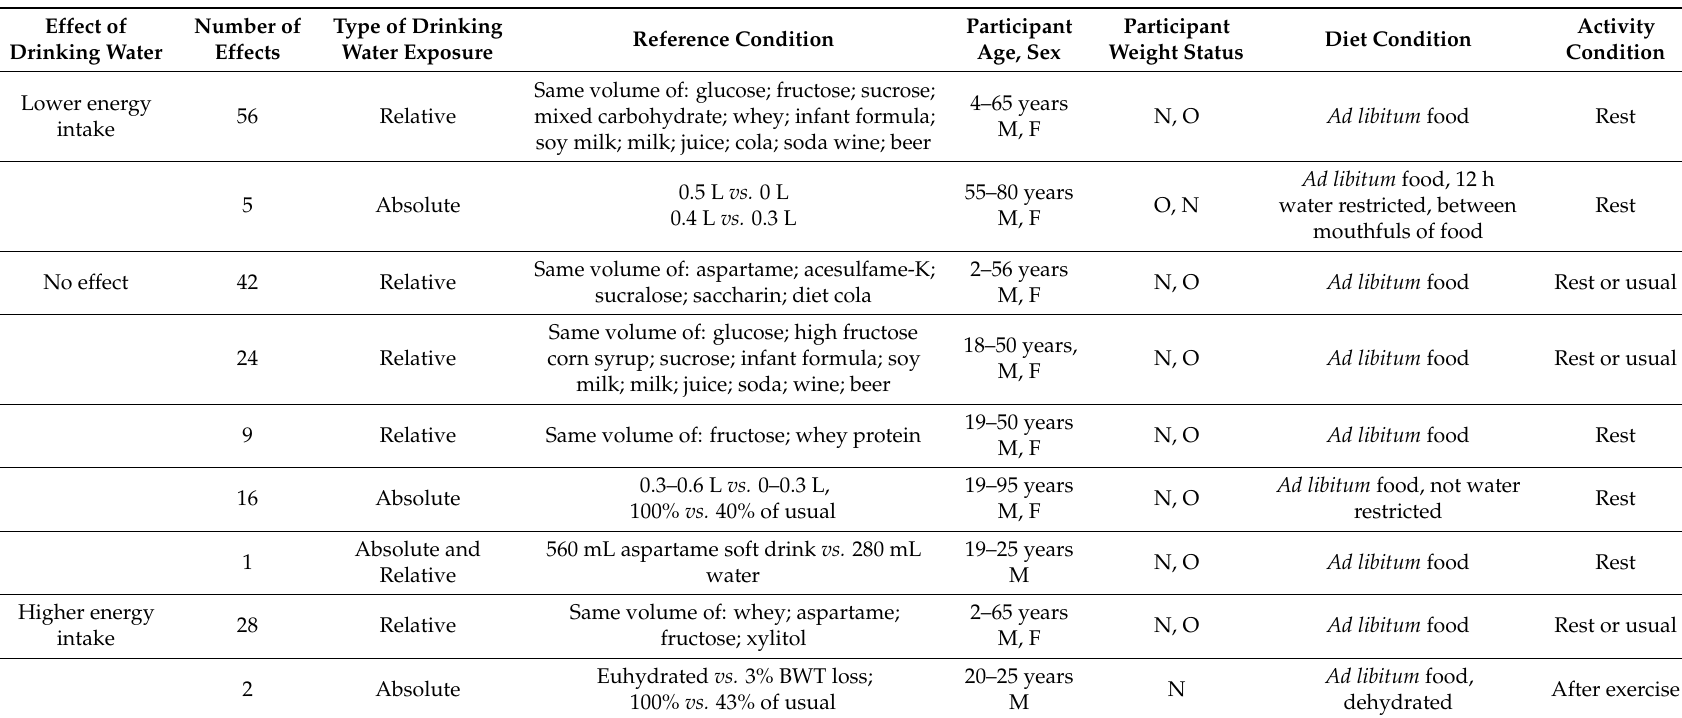
Table 2. RCT conditions associated with negative, null and positive effects of plain drinking water on energy